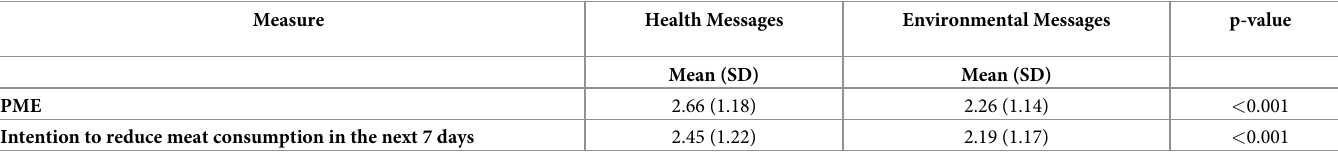
Table 4. Perceived message effectiveness (PME) � and intention to reduce meat consumption in the next seven days � between health and environmental messages.